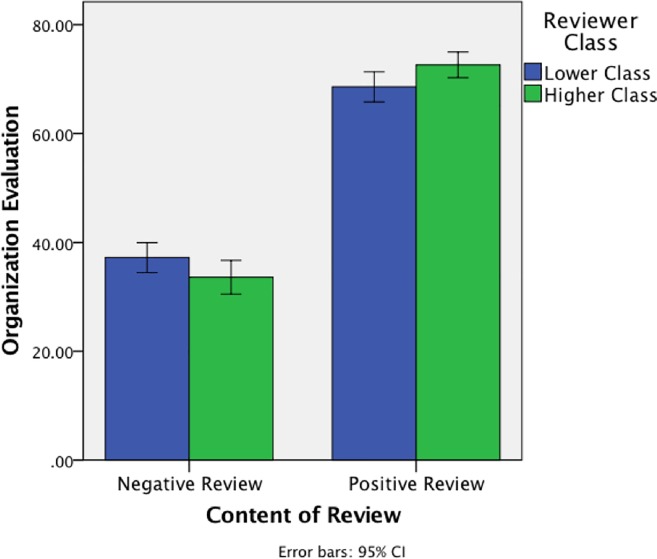
Means from Study 3 showing the interaction between review Positivity and Reviewer Class, collapsed across Organization Status conditions.